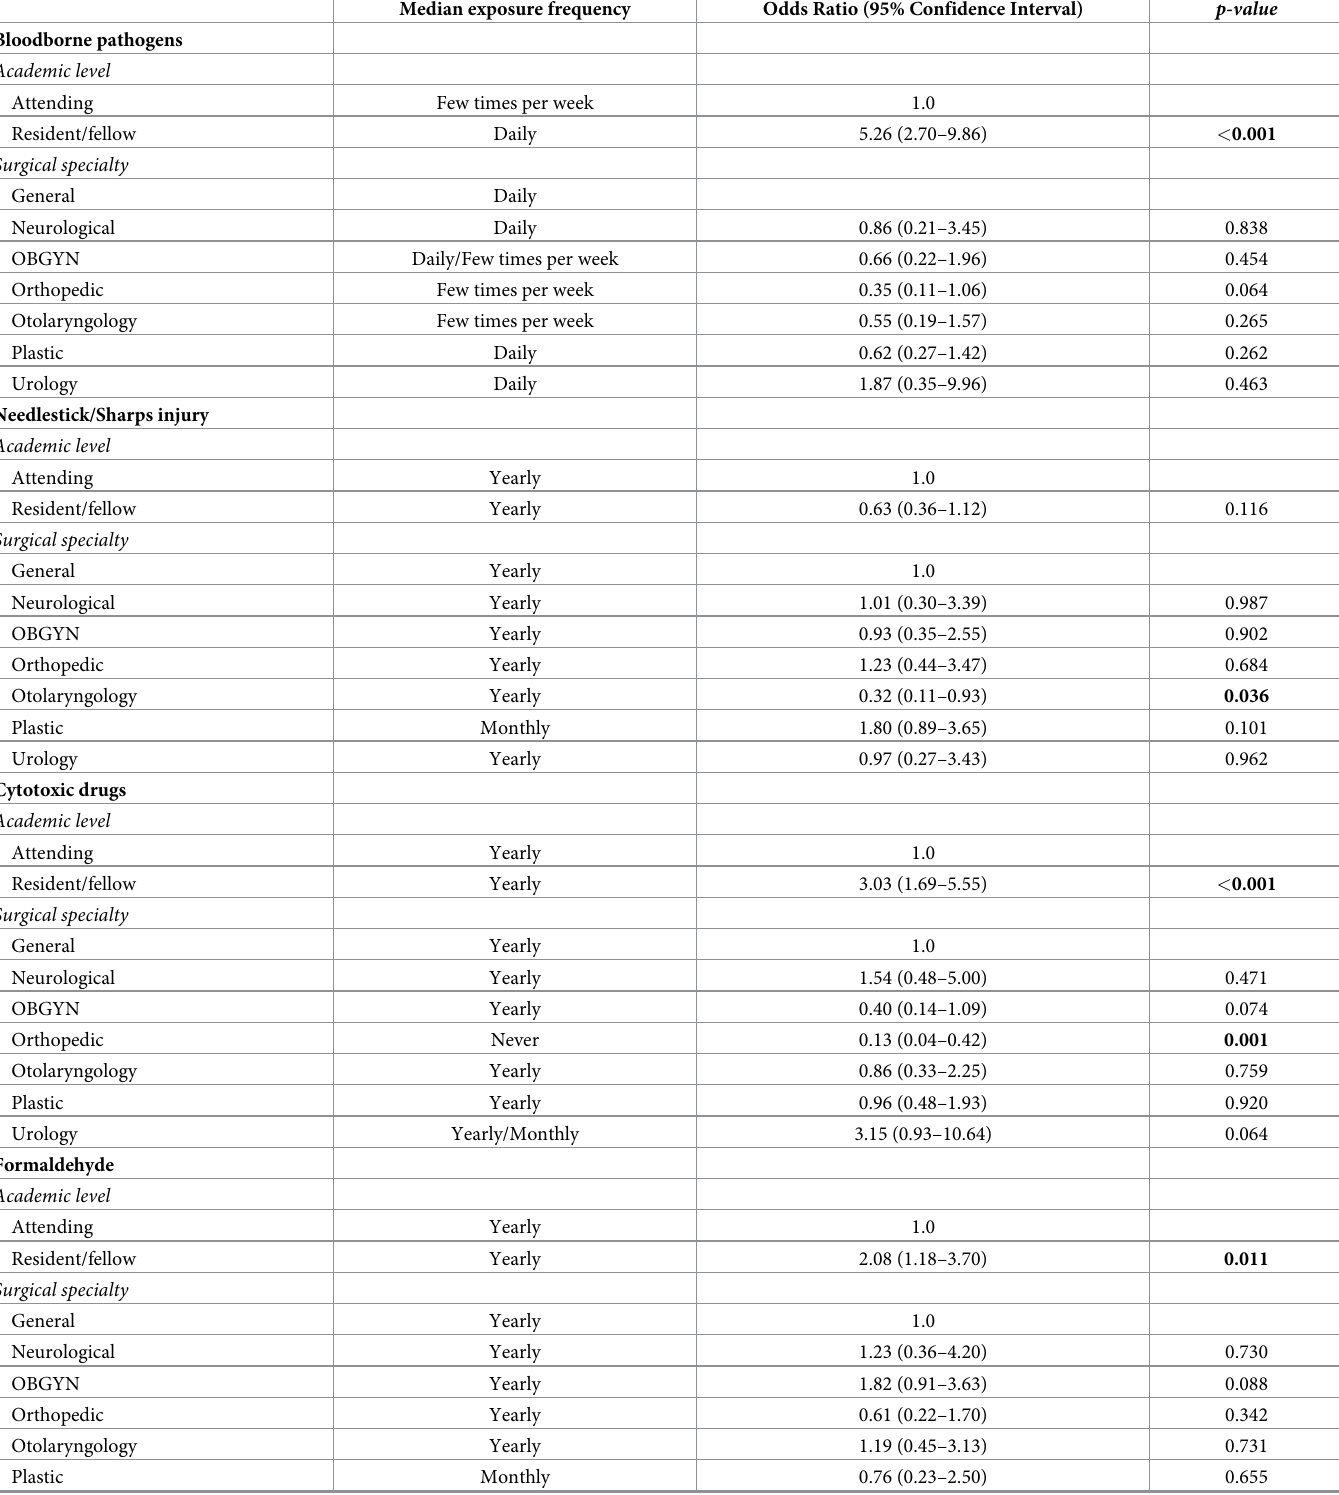
Table 4. Median frequency of exposure and odds of increased exposure to occupational operating room hazards stratified by academic level and surgical